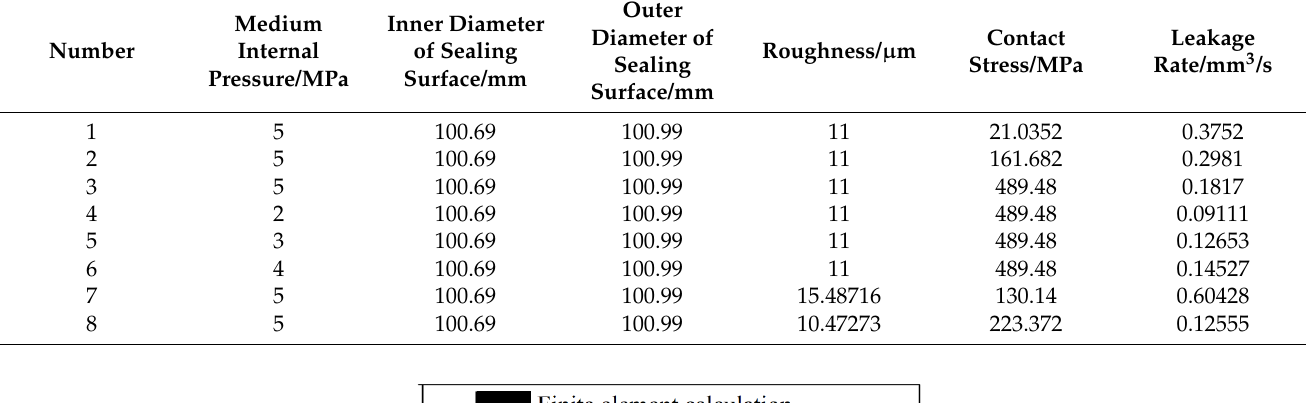
Table 3. CalculationresultsoftheleakagerateoftheNiTialloycorrugatedgasketunderdifferentparameters.